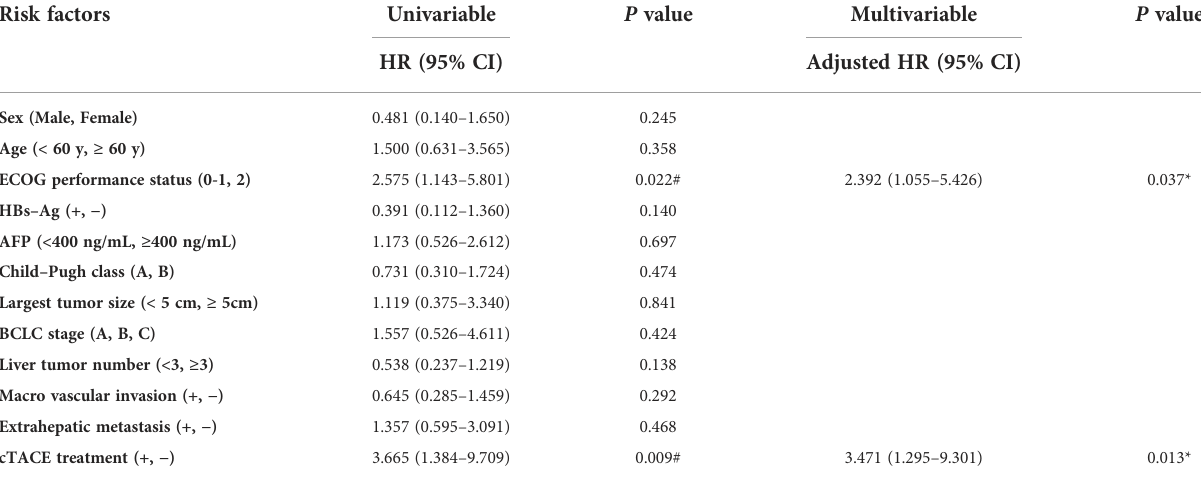
TABLE 5 Potential risk factors for OS across the entire cohort.